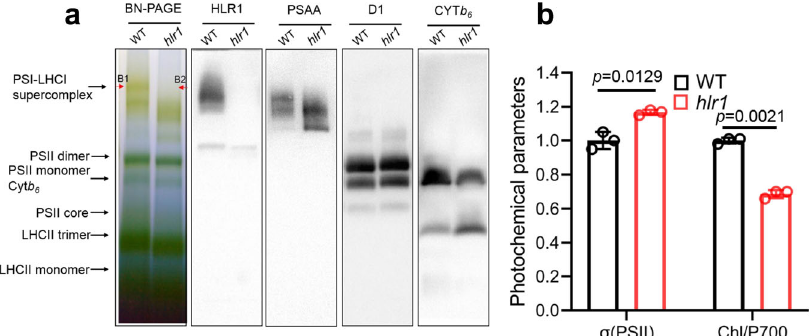
Fig. 3 Effects of HLR1 defect on the organization of the photosystems in WT and the hlr1 mutant. a BN-PAGE and immunoblot analysis of supernatant from solubilized thylakoid membranes from WT and the hlr1 mutant. Protein complexes were identi fi ed with appropriate antibodies. The excised bands from the BN-PAGE for mass spectrometry analysis are indicated as B1 (of WT) and B2 (of hlr1 ). b Spectrophotometric measurement of the absorption cross-section of PSII and the relative Chl and PSI content of WT and the hlr1 mutant. Data are presented as means± SD ( n = 3). The P values with signi fi cance